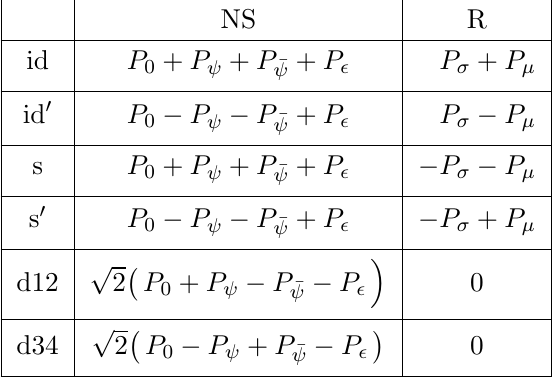
Table 9 . Explicit forms of the defect operators in the fermionic Ising model.